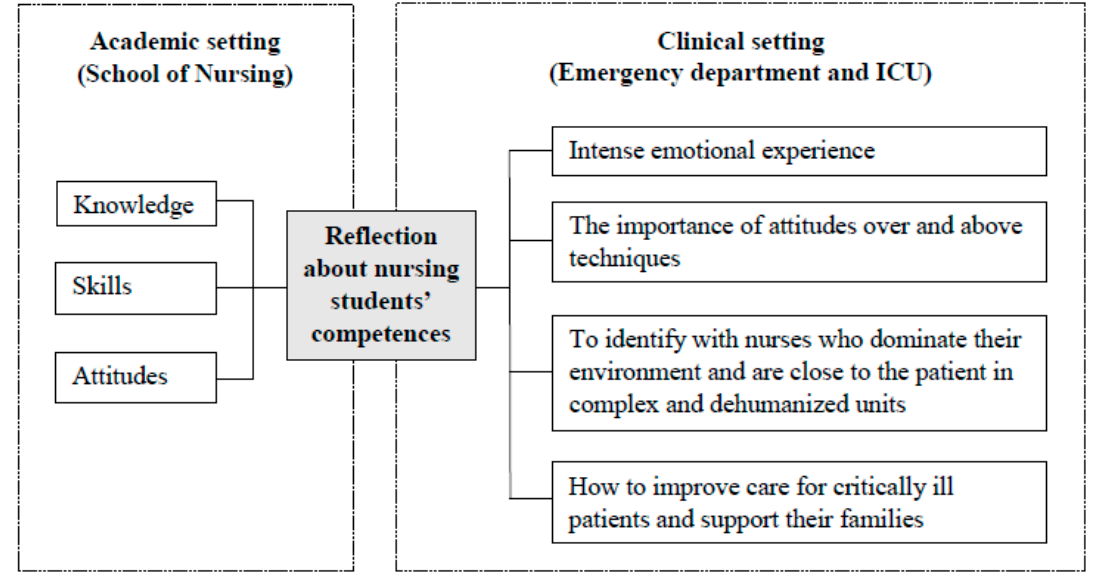
Figure 1. Experience of nursing students in emergency department and ICU during clinical practices. Table 1. Main categories, sub-categories and codes about the theme “intense emotional